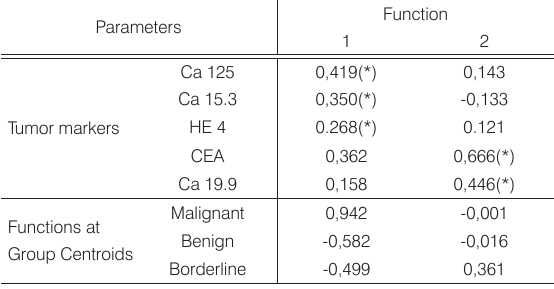
Table 2. Correlation coefficients between discriminating variables and standardized canonical discriminant function and group centroids of discriminant